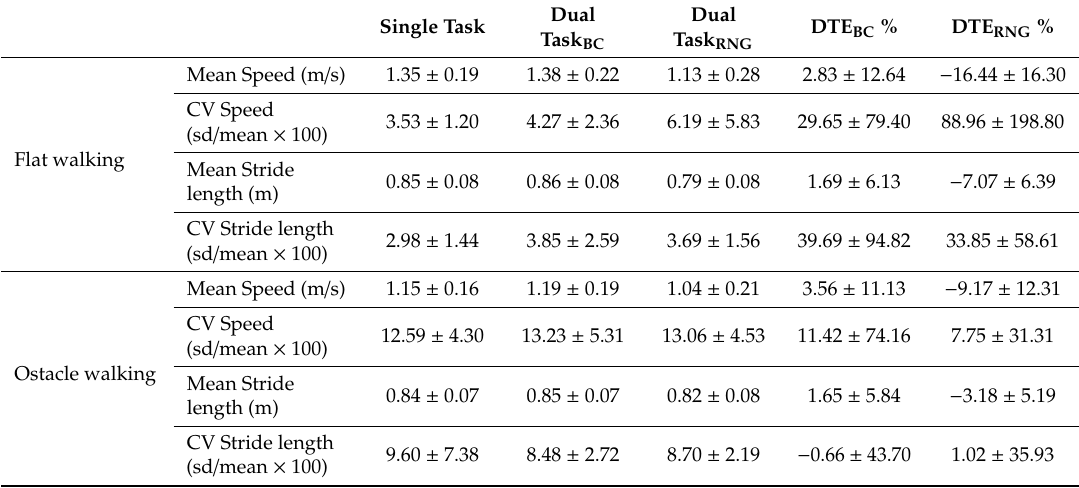
Table 4. Means and standard deviations ( n = 135) of gait variables in all testing conditions: low versus high environmental constraints on walking (flat versus obstacle) in single task (ST) or dual task (DT) with low versus high cognitive demands (backward counting (BC) versus random number generation